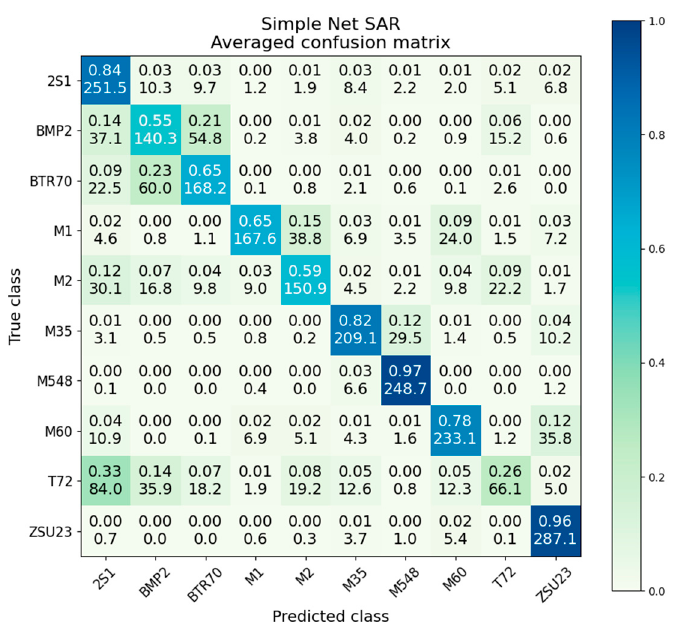
Figure 8. ResNet18 SAR-only accuracy distributions during training.